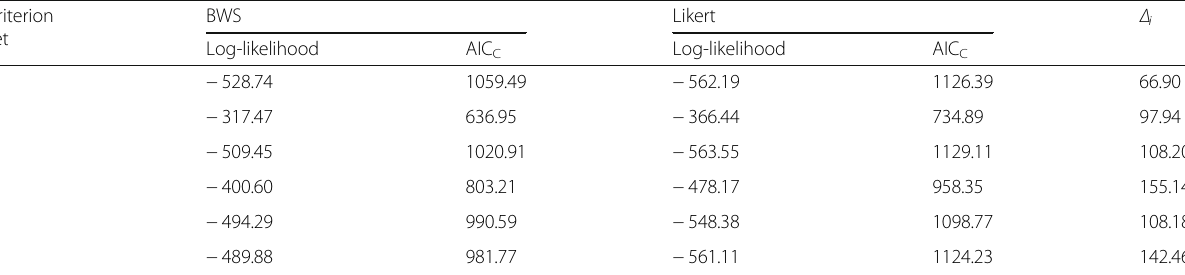
Table 1 Log-likelihoods and AIC C s for the rank-ordered logistic regression models predicting participants ’ rankings for each criterion set from their BWS or Likert scores. Higher log-likelihoods, and lower values of Akaike ’ s bias-corrected information criterion (AICC) (i.e. closer to zero for both measures) indicate better model fit. Models using best-worst scaling (BWS) scores achieved better fit for each of the six criterion sets. This improvement is reflected by the difference between AIC C values for the two models ( Δ i ), which are > 10 for all criterion sets, indicating a substantial improvement in model fit (Symonds & Moussalli, 2011) Criterion set